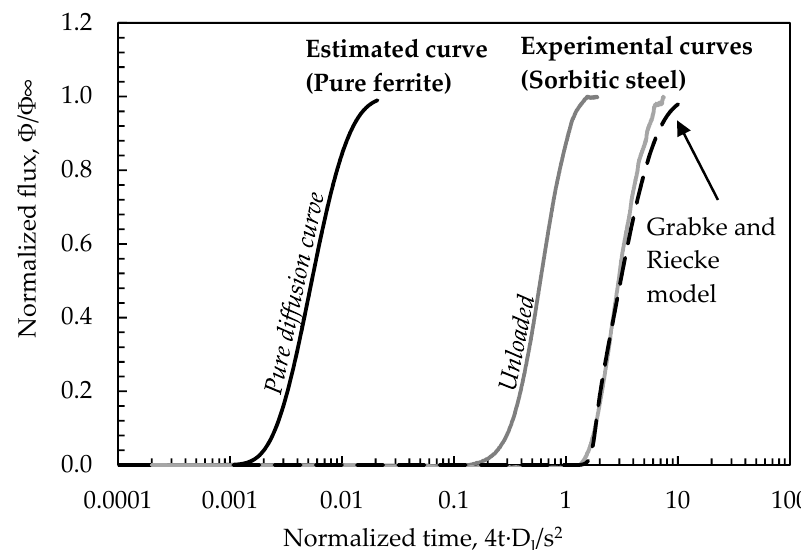
Figure 3. Experimental permeation curves as adimensional flux/adimensional time ( Φ = hydrogen flux; Φ ∞ = steady state flux; t = permeation time; s = thickness): Comparison between the modeled permeation curve and the experimental data curve.